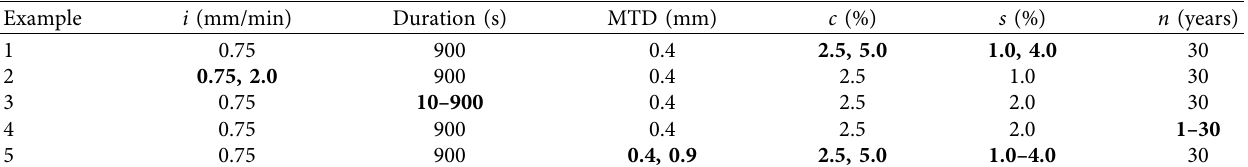
Table 1: Simulation parameters for numerical examples of surface drainage (influencing quantities highlighted in bold).